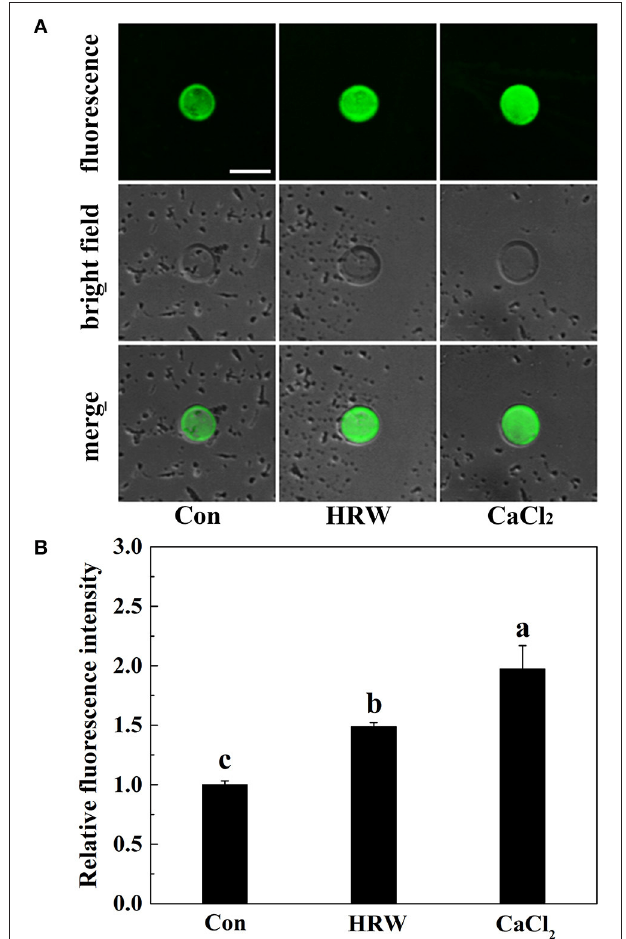
FIGURE 2 | Changes of cytosolic calcium concentration in protoplasts of radish mesophyll cells. Radish mesophyll protoplasts were loaded with Fluo-3/AM, and then incubated in an isotonic solution containing 10mM CaCl 2 or HRW (100% saturation) for 2h under UV-A irradiation. Afterwards, the fluorescence of Fluo-3/AM was detected by LSCM (A) . Bar = 50 µ m. The typical fluorescence images (A) and corresponding fluorescence intensities (B) were given. The sample with isotonic solution alone was the control (Con). The fluorescence intensities are mean ± SE ( n = 3). Bars with different letters are significantly different in comparison with Con at P < 0.05 according to Duncan’s multiple